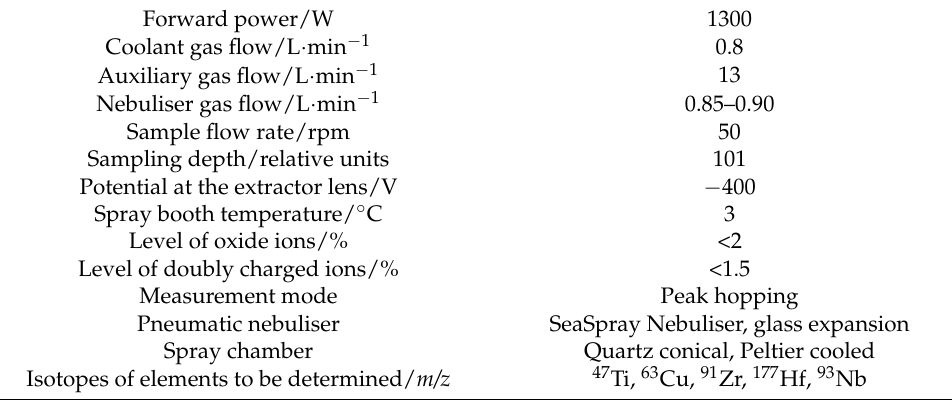
Table 2. Instrumental operating conditions of mass